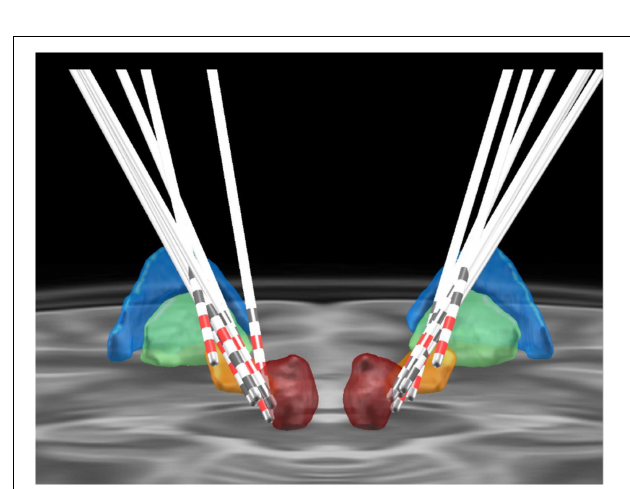
FIGURE 1 | 3 T magnetic resonance images. Target coordinates of the posterior subthalamic area (PSA) were 10 mm lateral, 7.7 mm anterior, and 3.4 mm superior. PSA (green) and ventral intermediate nucleus of the thalamus (red) contacts. (A) Coronal T2-weighted image. (B) Horizontal T1-weighted image. (C) Sagittal T1-weighted image.